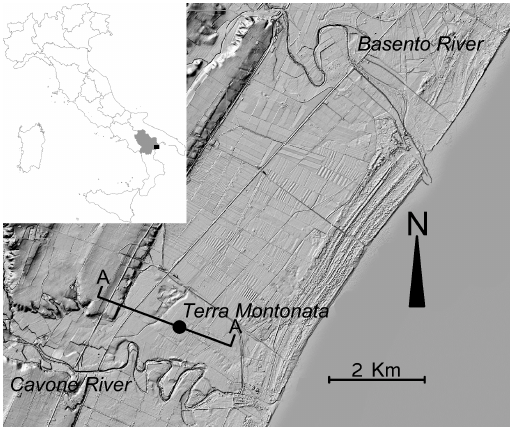
Figure 1. Location of study area with the indication of Terra Montonata monitoring station used in this study and the trace of cross section A–A illustrated in Figure 2.